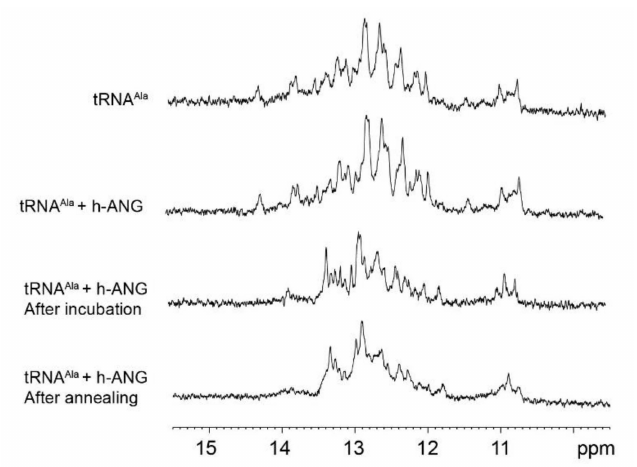
Figure 7. 1D 1 H Spectra of tRNA Ala (imino HN region) before and after h-ANG cleavage. The top spectrum corresponds to tRNA Ala in KPi buffer. The second spectrum from the top shows the imino region upon addition of 1 / 20 molar equivalent of h-ANG protein. The next spectrum (third from the top) corresponds to the previous RNA:h-ANG mixture after ON incubation. The bottom spectrum belongs to the mixture after being subjected to annealing at 90 ◦ C for 10 min and slow cooling down to room